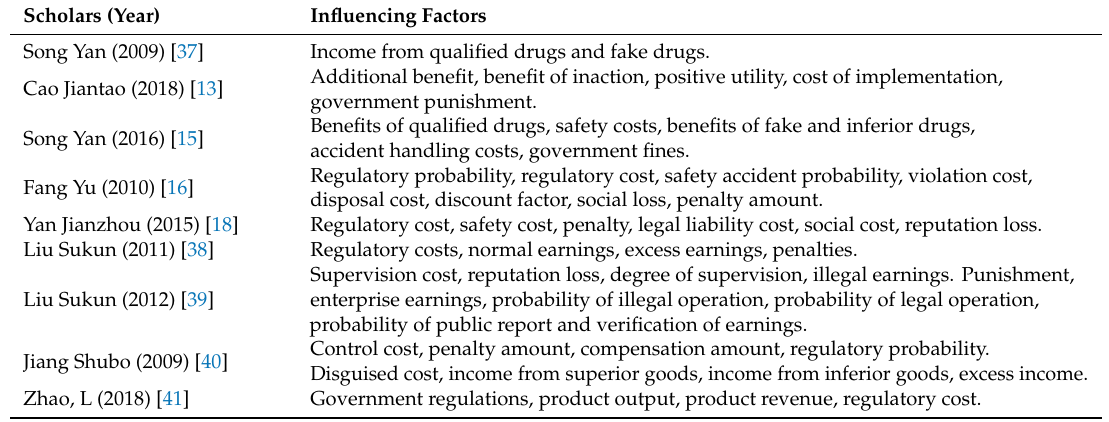
Influencing factors of drug (food) enterprise behavior decision under government supervision mode. Influencing